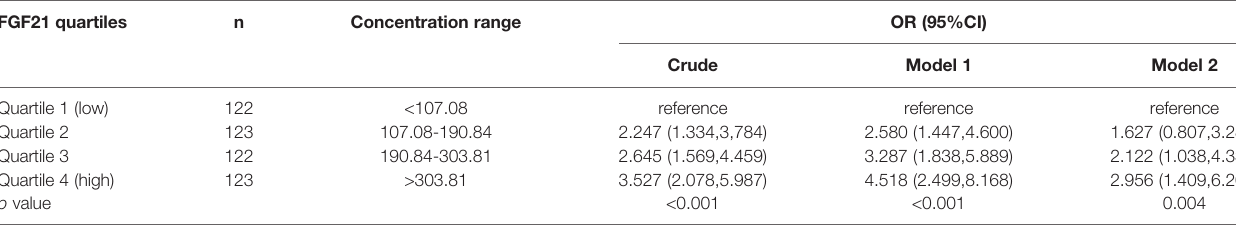
TABLE 2 | Association of CAD with serum FGF21 in T2DM men.